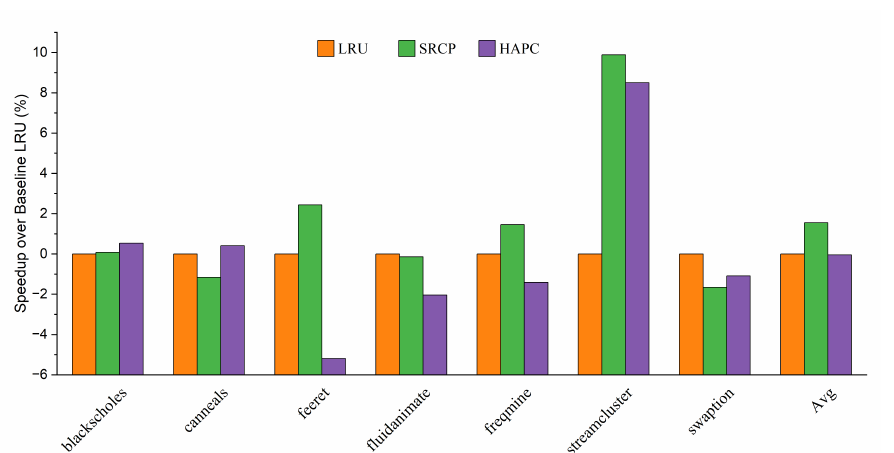
Figure 5. Speedup over baseline LRU of little